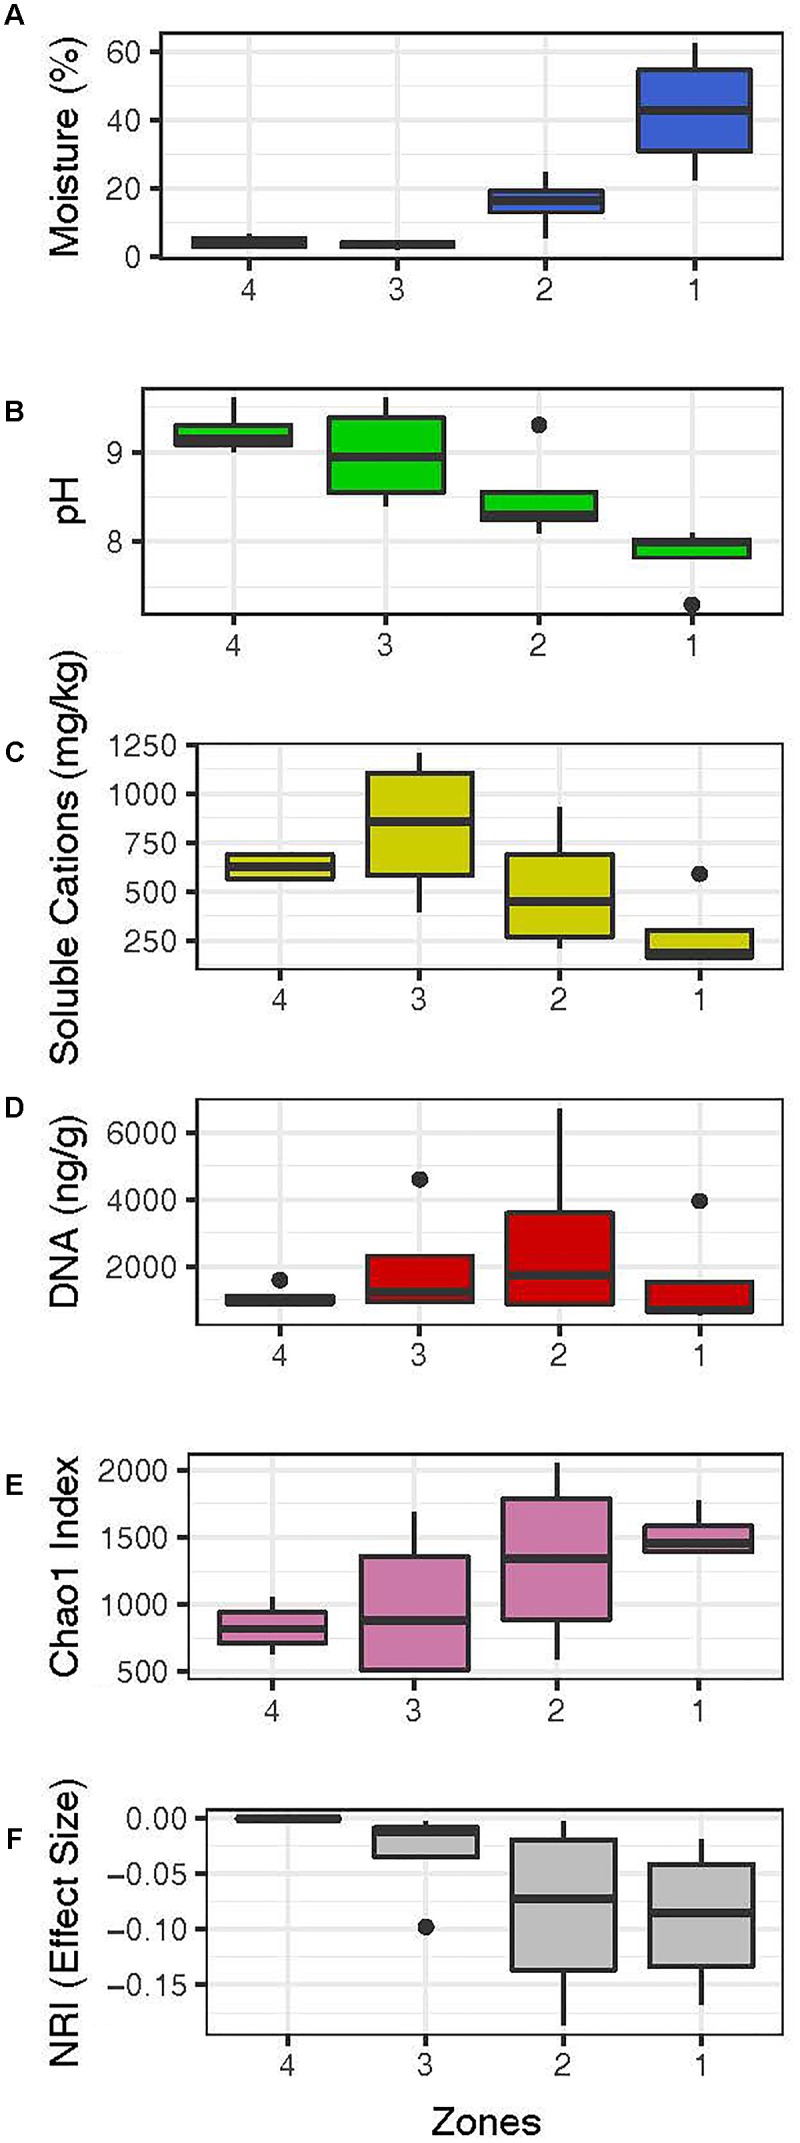
Summary of abiotic and biotic trends for soil moisture zones, from driest furthest from the pond (zone 4, 2.2%) to wettest at the water’s edge (zone 1, 62.56%). Full data for abiotic and biotic data at every moisture increment within each of the zones 1–4 are given in Figures 2, 6, 7.